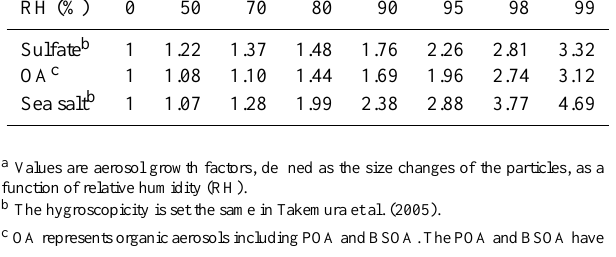
On-line On-line